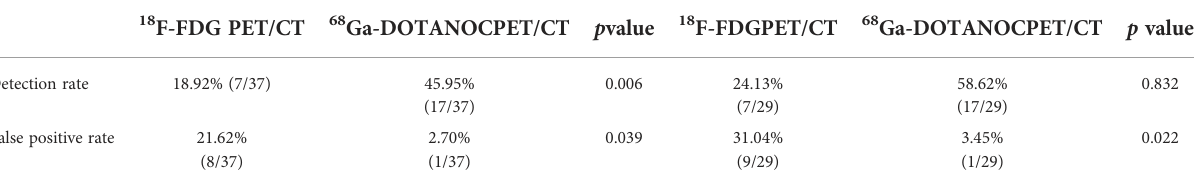
TABLE 2 PET/CT scan-based and lesion-based diagnostic results for patients with ectopic ACTH syndrome in the tumour localization group. Scan-based analysis (n=37)